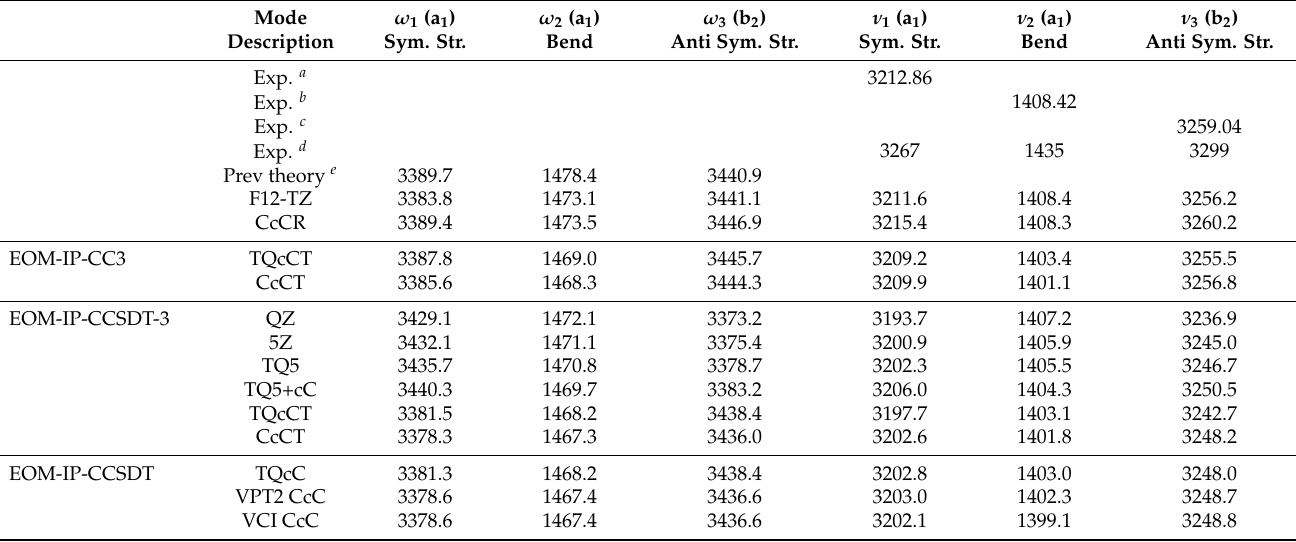
Table 4. ˜X 2 B 1 H 2 O + Vibrational Frequencies in cm − 1 .